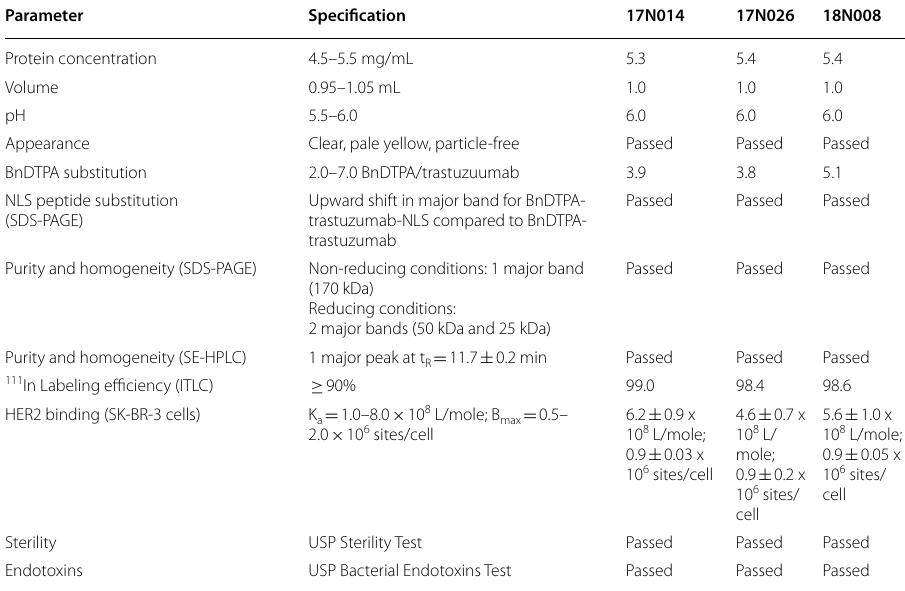
Table 1 Quality testing results for three sequential lots of kits for the preparation of 111 In[In]- BnDTPA-trastuzumab-NLS